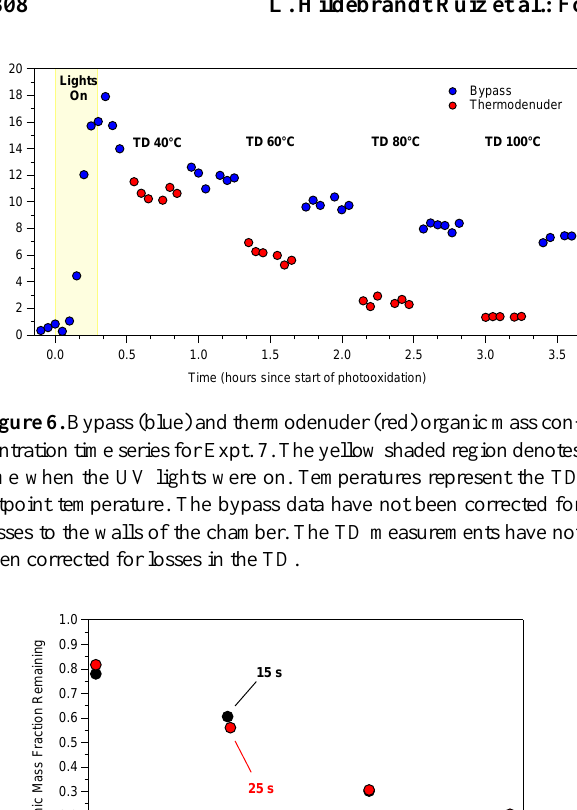
volatility (Sect. 3.3) or hygroscopicity (Sect. 3.4). This sug-